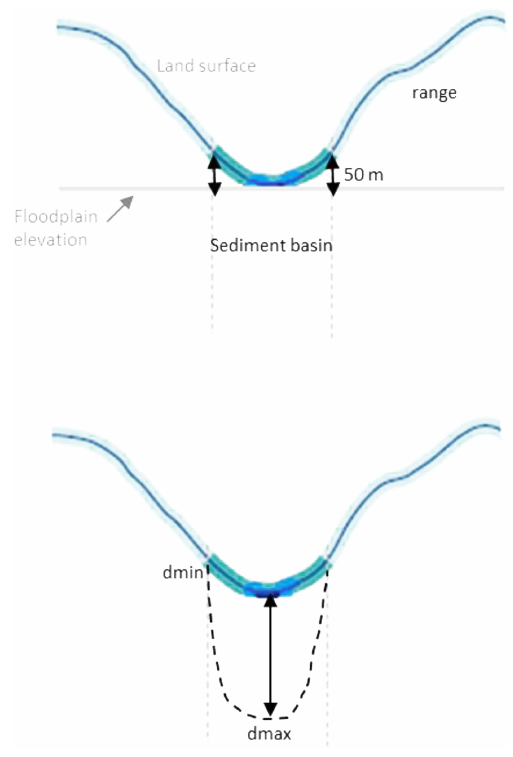
Figure 2. Top panel: definition of sediment basins and mountain ranges, based on terrain attributes (land-surface elevation and flood- plain elevation). Bottom panel: estimation of aquifer